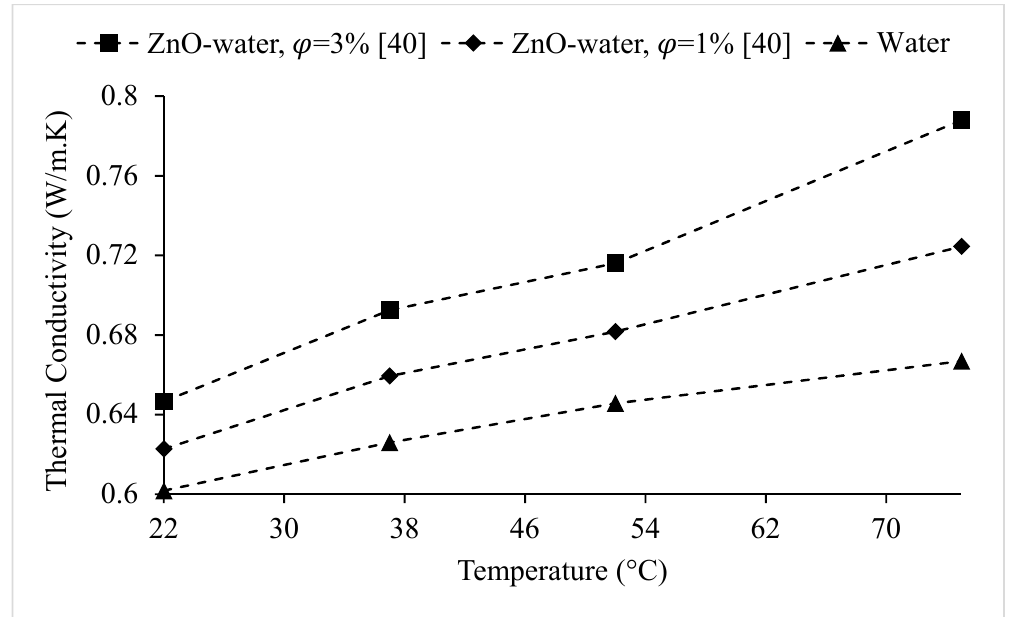
Figure 22. Variation of the thermal conductivity of ZnO–water nanofluid at various nanoparticle volume concentrations, as a function of temperature.